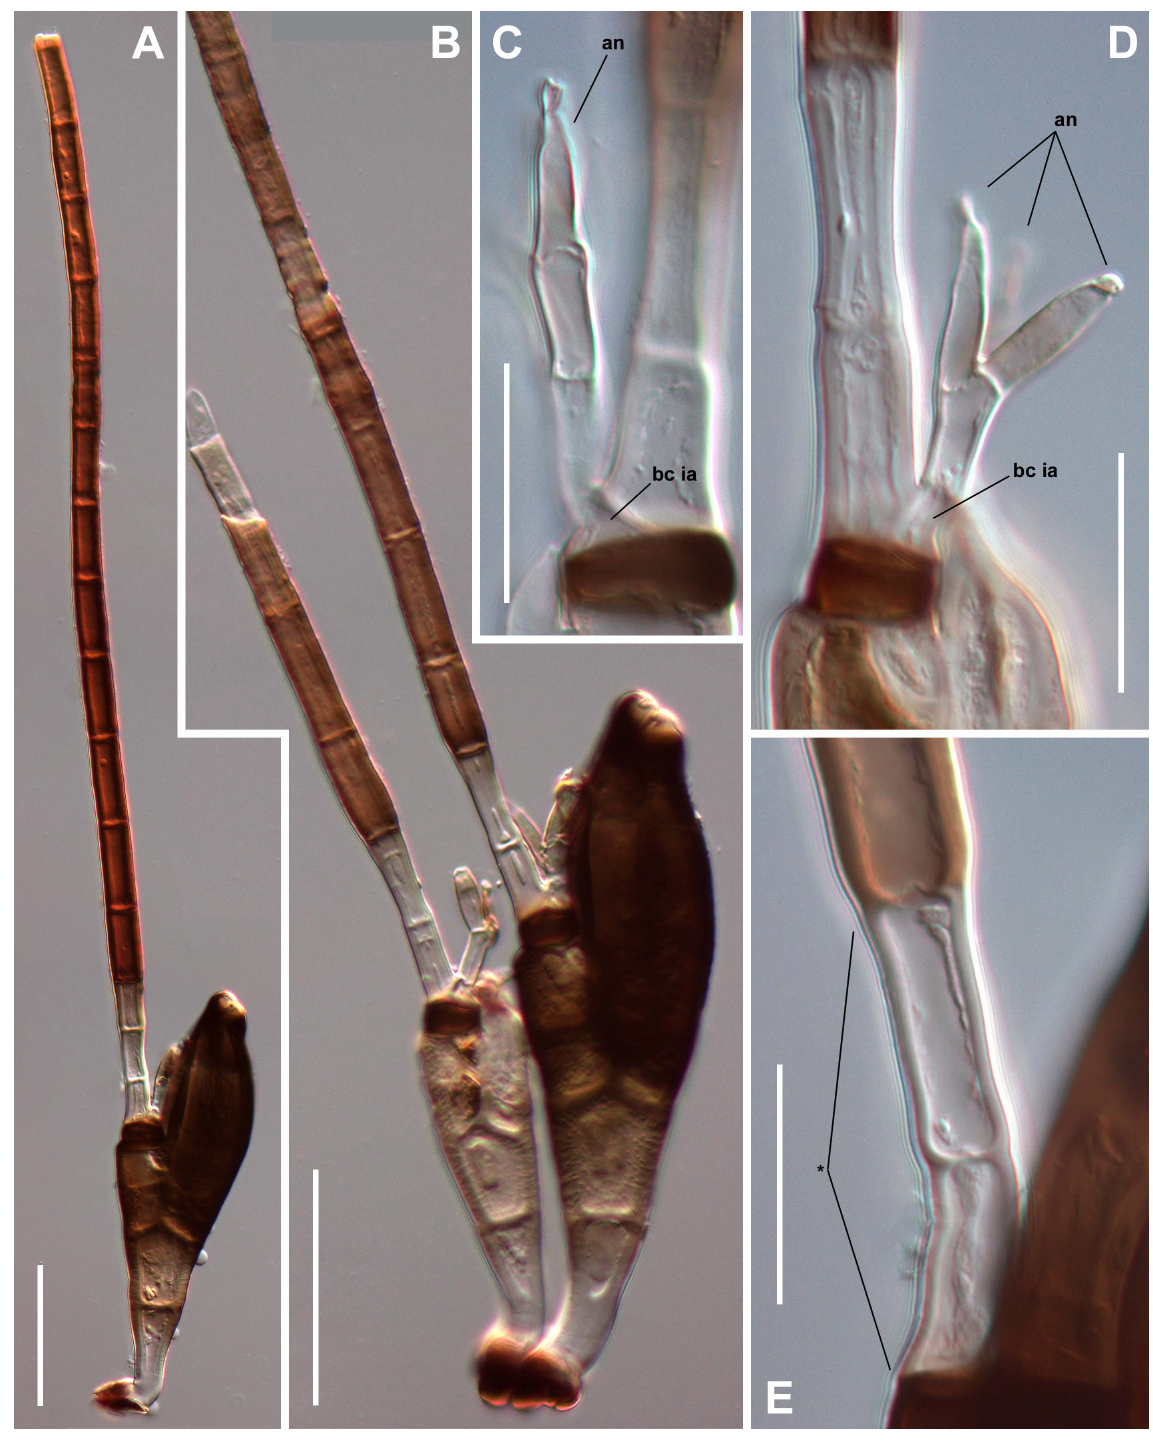
Fig. 34. Laboulbenia inexpectata Santam. sp. nov. A . Mature thallus. B . Paired mature and immature thalli. C – D . Inner appendage and lower part of outer appendage in detail, with labelled antheridia (an) and basal cell of inner appendage (bc ia). E . Lower cells of outer appendage in detail (*). Scale bars: A–B = 50 µm; C–E = 20 µm. Photographs from slides ZMUC C-F-122502 (holotype) (A–B), ZMUC C-F-122504 (C, E), ZMUC C-F-122503